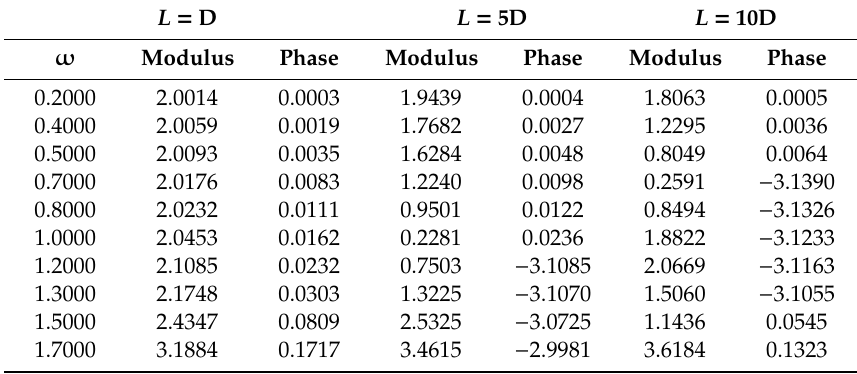
Table A2. Heave responses (modulus and phase) of the 1st WEC device for the C 2 arrangement. L = D L =